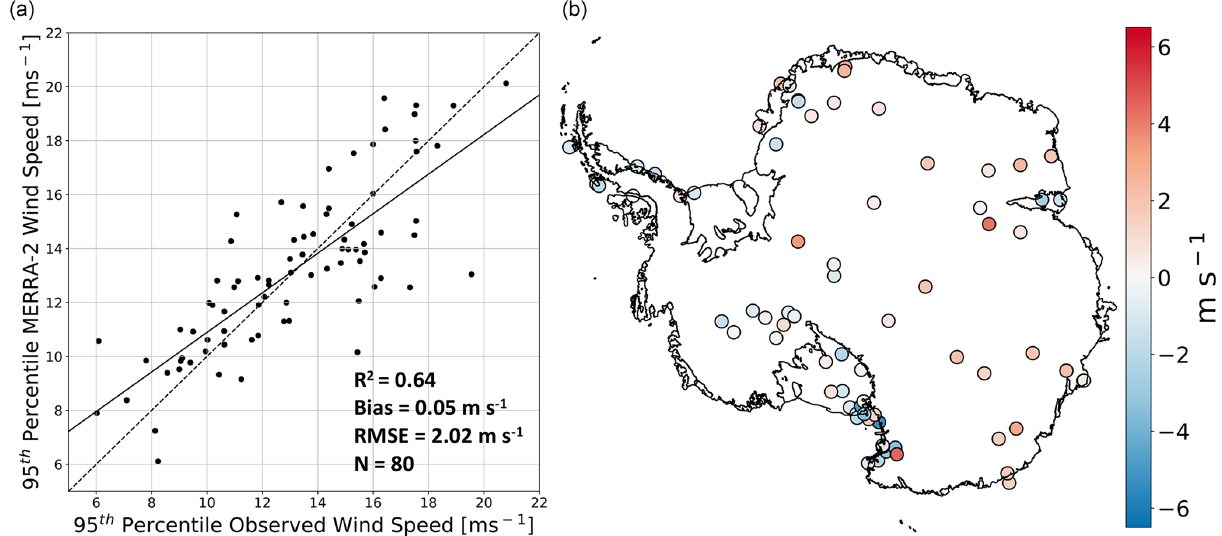
Figure 4. Evaluation of MERRA-2 95th percentile hourly wind speeds. Scatter plot (a) of observed vs. MERRA-2-simulated 95th percentile hourly 10m wind speeds at 80 automatic weather stations scattered across the Antarctic ice sheet. Map of MERRA-2 minus observed 95th percentile hourly wind speeds (b)